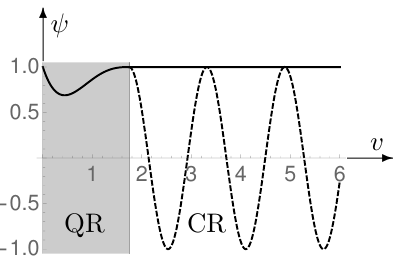
Figure 4. Joint representation of the HH-like QR-solution ψ ( v ) and the CR-solution ψ c ( v ) , the latter being shown a second time in dashed style and with strong horizontal